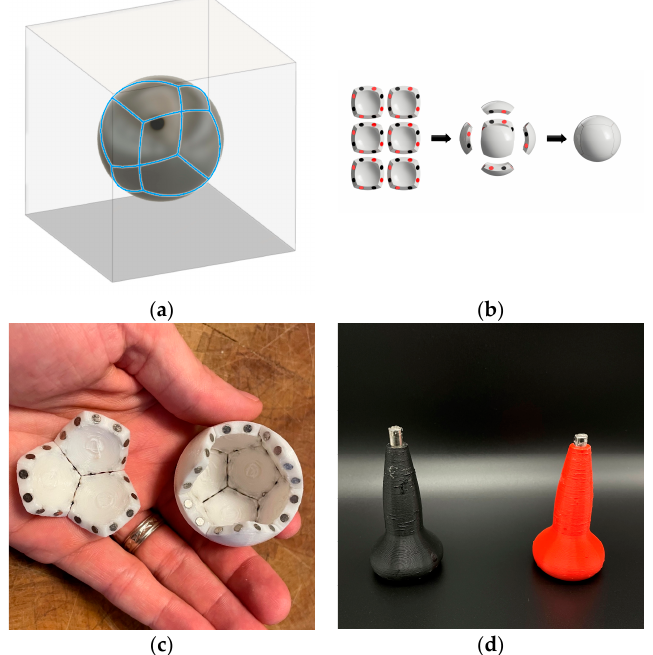
Table 3. Self-Assembly Times (in seconds) of Ten Trials with the Icosahedron in Different Contain- ers. Type